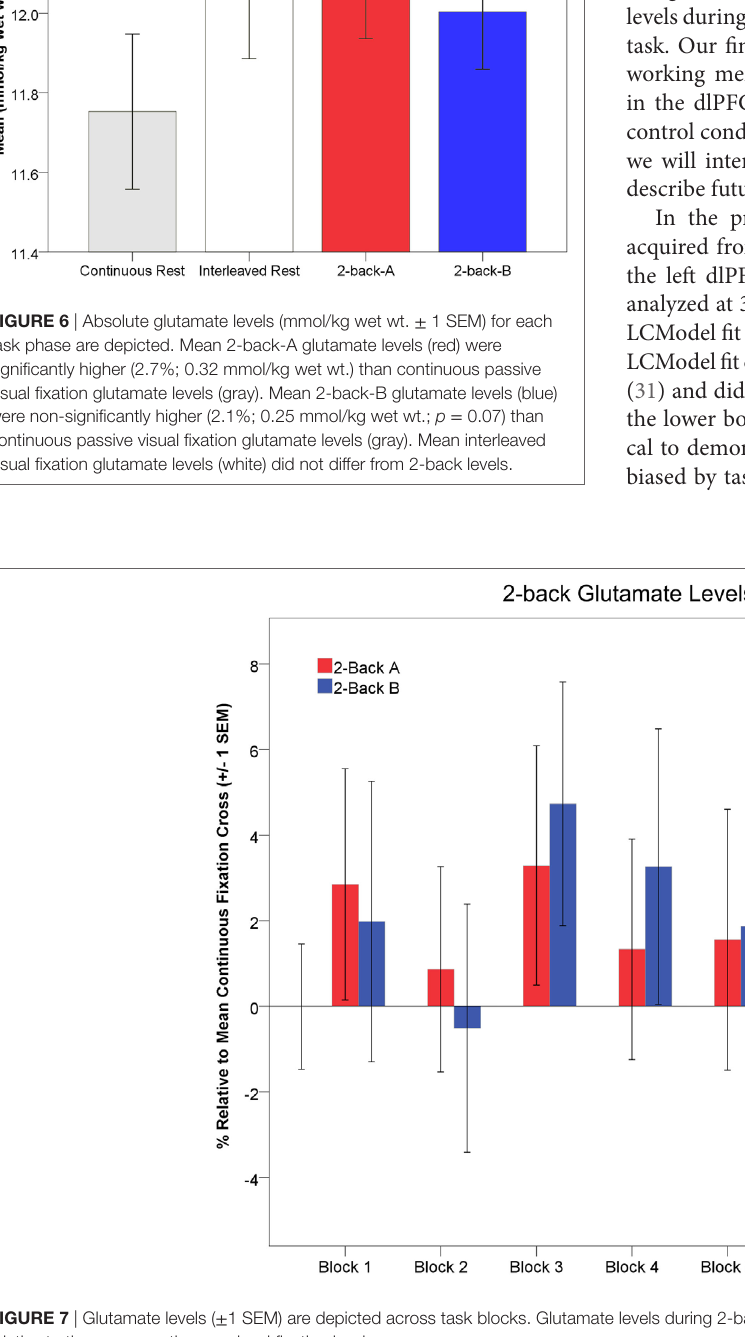
FigUre 7 | Glutamate levels ( ± 1 SEM) are depicted across task blocks. Glutamate levels during 2-back-A (red) and 2-back-B (blue) are depicted as a percentage relative to the mean continuous visual fixation levels.